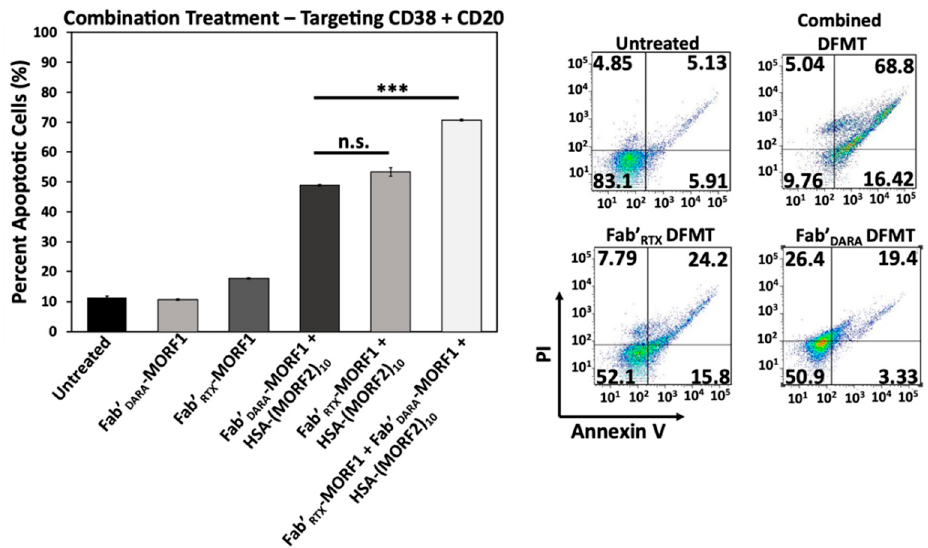
Figure 7. Combinational DFMT treatment of Raji cells with CD38-targeting Fab’ DARA DFMT coupled with CD20-targeting Fab’ RTX DFMT. The combined treatment was compared to individual therapies at the same MORF1 equivalence. Percent apoptotic cells were determined after DFMT treatment and analyzed with Annexin V/Propidium Iodide staining via flow cytometry. All experiments were performed in triplicate and statistically analyzed by One-Way ANOVA and Tukey test. *** p < 0.001, n.s.